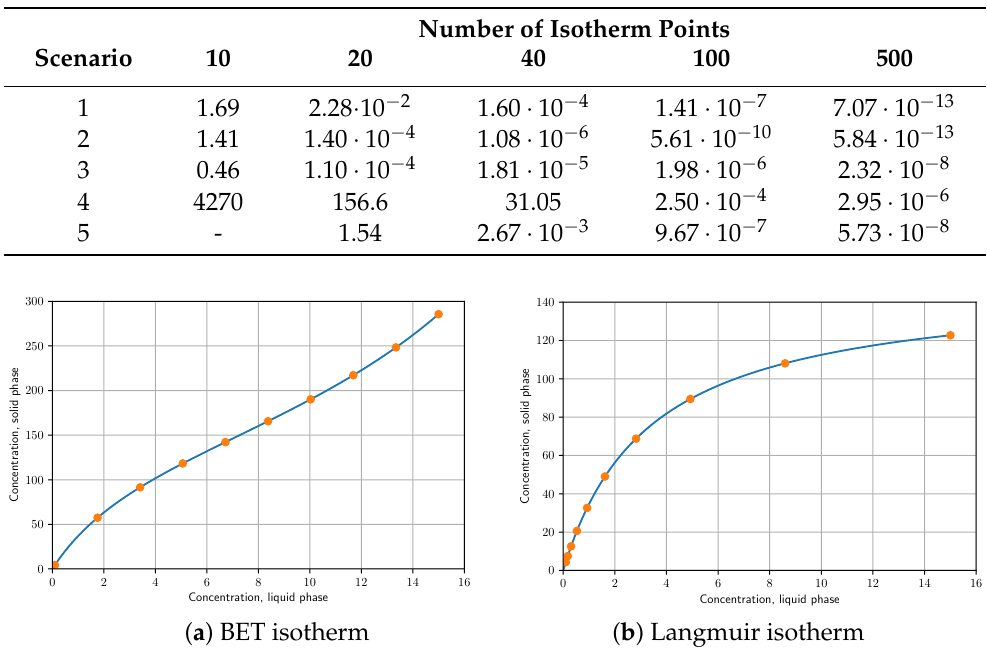
Figure 1. Optimal distribution of isotherm points for convex ( a ) and concave isotherm ( b